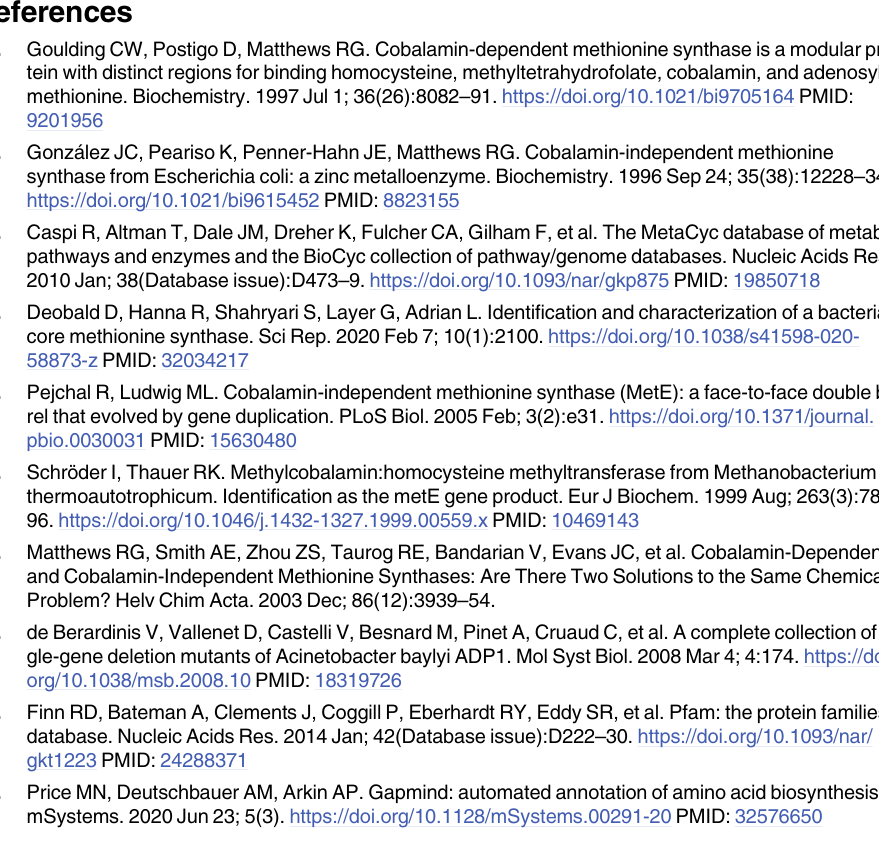
S1 Table. The taxonomic distribution of methionine synthases across UniProt’s reference proteomes. S1 Fig. Gene fitness from Sphingomonas koreensis growing in minimal glutamate media with or without